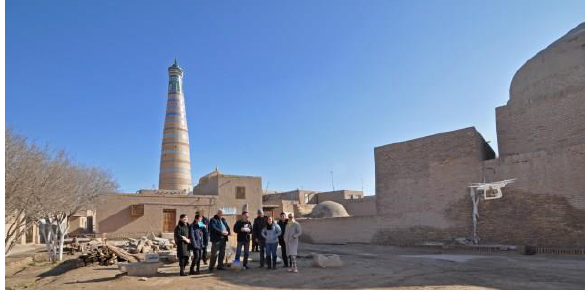
Figure 14 . Team receiving training and hands-on to fly a drone provided by the authors and supported by the CAAL